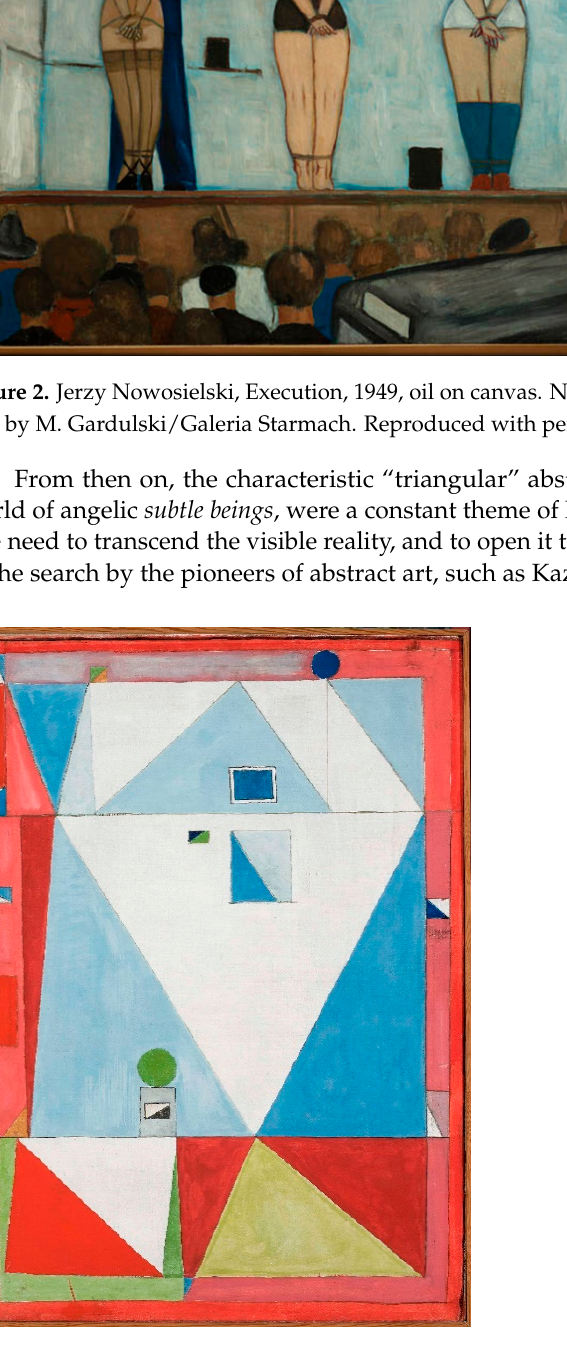
Figure 3. Jerzy Nowosielski, Big triangles, 1958, oil on canvas. National Museum in Warsaw. Photography by M. Gardulski/Galeria Starmach. Reproduced with permission.